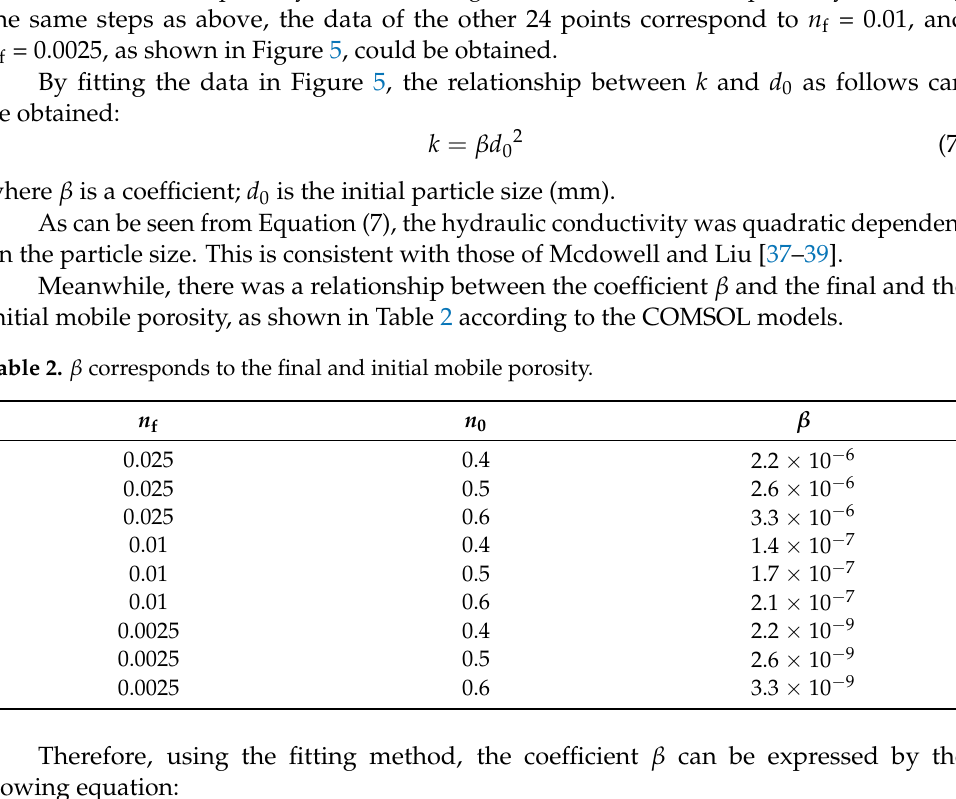
Table 3. The experimental hydraulic conductivity of the GCLs [2,42–44].